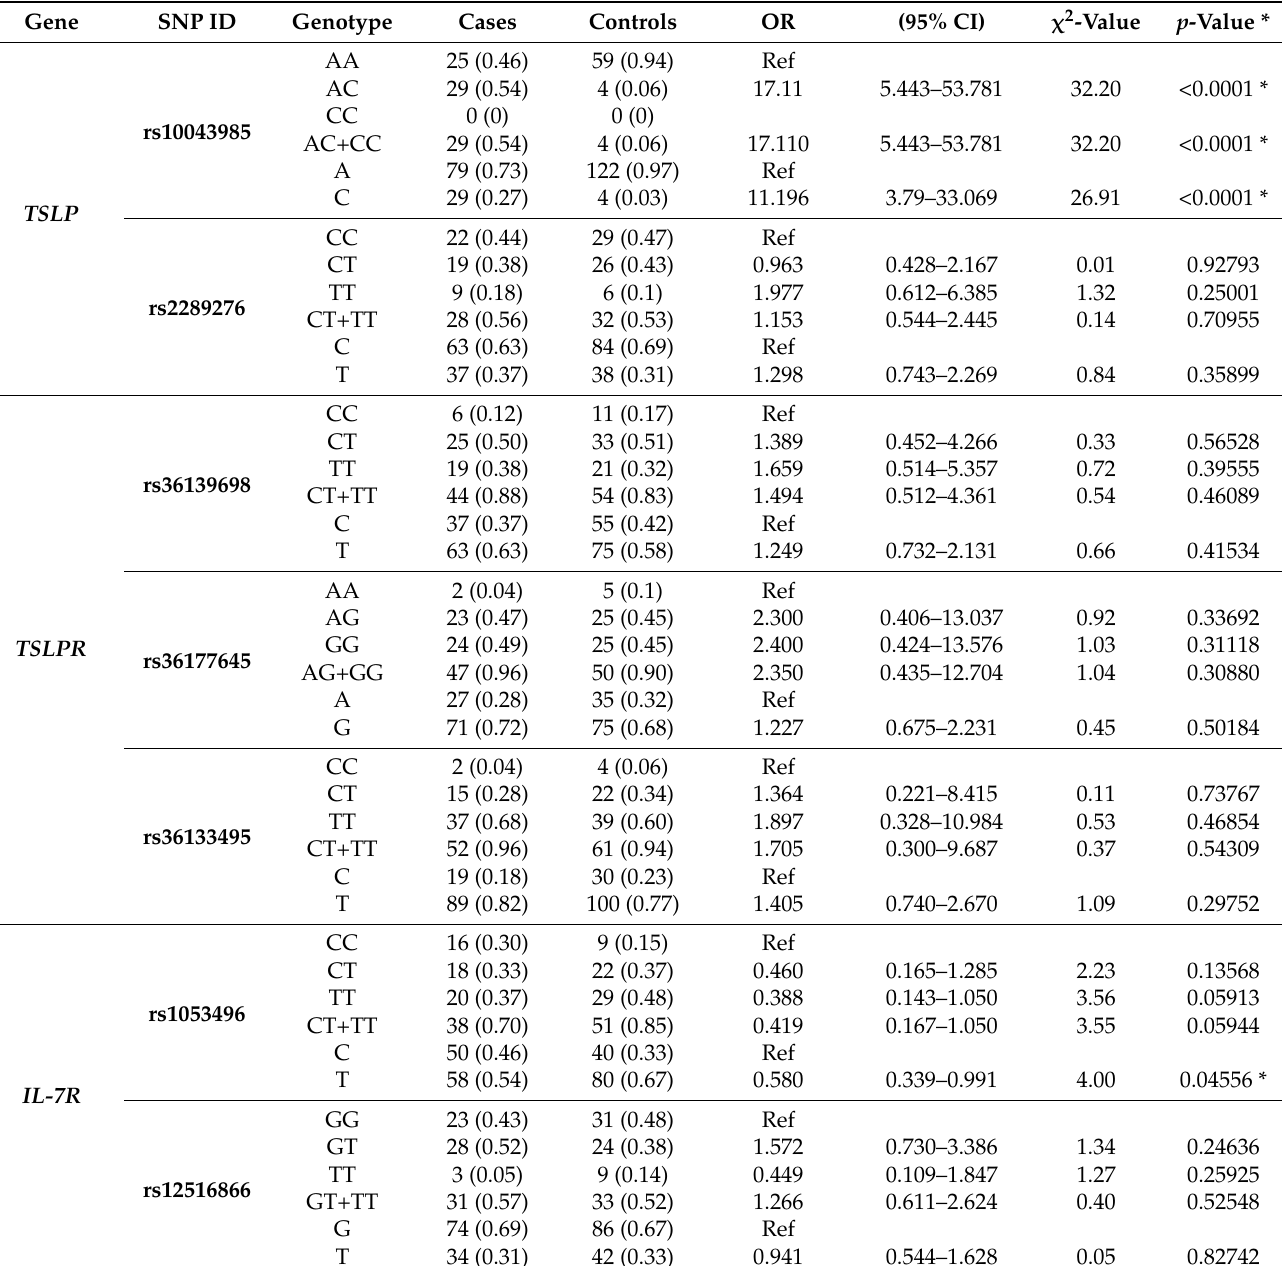
Table 5. Genotype frequencies of TSLP, TSLPR, and IL-7R gene polymorphisms in CRC and controls in individuals below 57 years of